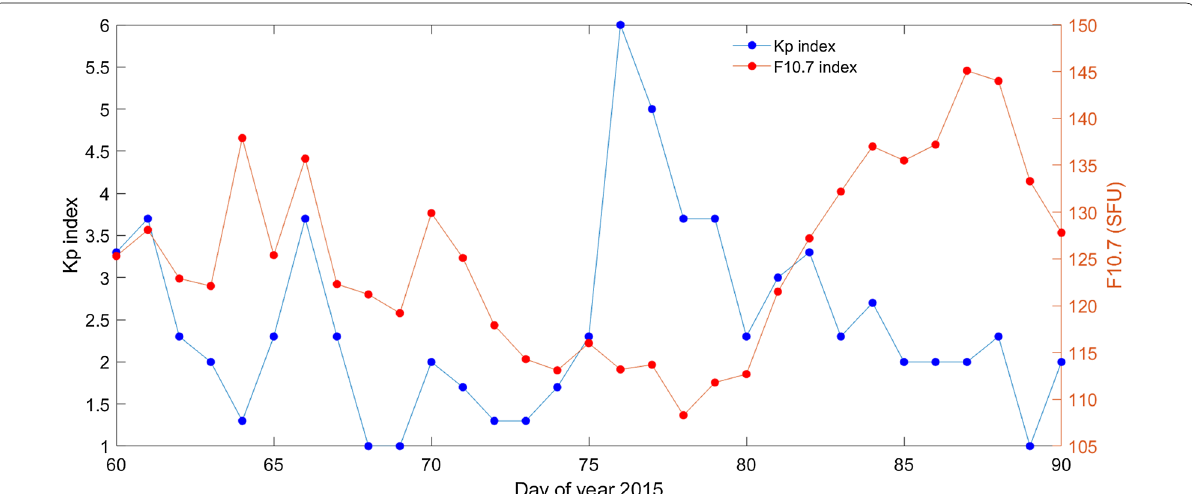
Fig. 11 Space weather situation in March 2015 is shown using the daily averaged time series of Kp and F10.7 indices. While Kp index is unitless, F10.7 has the unit of solar flux units (SFU) with 1 SFU = 10 − 22 Wm − 2 Hz − 1 . The values corresponding to the time window in Table 1 correspond to day of year (DOY) 71, 72 and 73 of year 2015. Data for Kp and F10.7 are downloaded from NASA omniweb explorer portal https:// omniw eb. gsfc. nasa. gov/ form/ dx1. html accessed on 26 June 2022